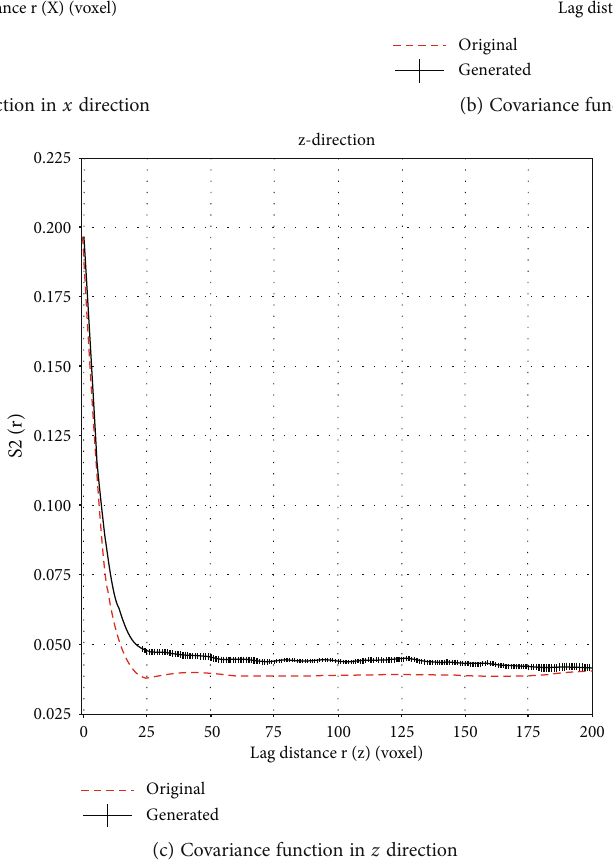
Figure 7: Comparison of covariance functions in x , y , and z trained 800 times, the pore shape and pore distribution have Figure 4 is a list of core images obtained by normal training good consistency with the original training sample, and 800 times, and Figure 5 is a list of core images obtained by there is good connectivity between the pores, indicating the using a pretrained discriminator. It can be seen that using core generation e ff ect better. Without pretraining, the core the pretrained discriminator, after the network model is